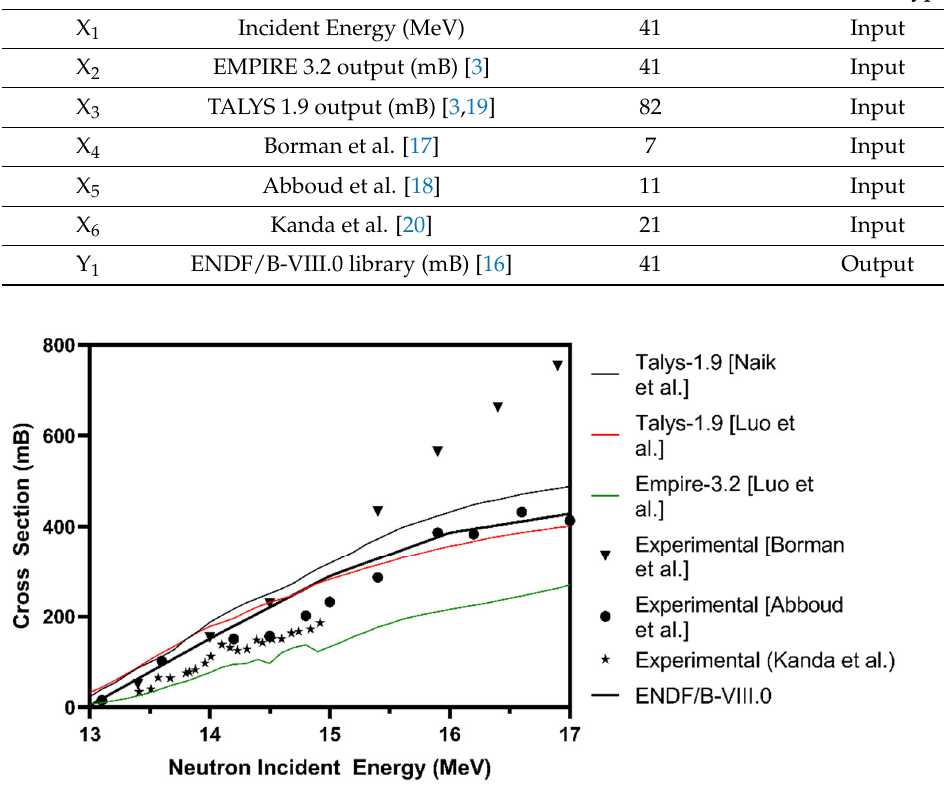
Figure 1. Graph of nuclear cross-section data of 92 Mo ( n ,2 N ) 91 Mo nuclear reaction from various lit- erature used in this work [3,17–19]. The neutron incident energy, is between 13 MeV to 17 MeV . Table 1. Variables used as the input and output for prediction of nuclear cross-section data of 92 Mo (, 2) 91 Mo. The experimental dataset (EXP) includes experimental data from Borman et al. [17], Abboud et al. [18] and Kanda et al. [20] while the crude estimation property (CEP) includes EMPIRE 3.2 and TALYS 1.9 data from Luo and Jiang 3 and TALYS1.9 data from Naik et al. [19]. Variable